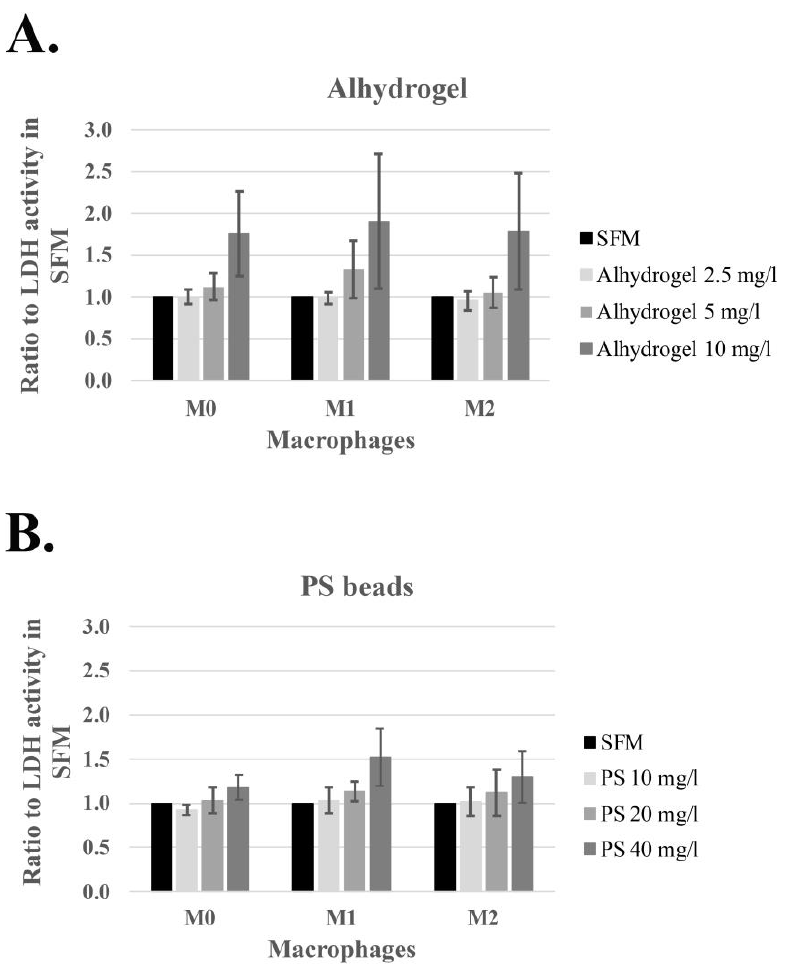
Figure 2. Increased LDH activity in culture medium from differentiated and polarized M0, M1, and M2 macrophages incubated for 24 h with Alhydrogel ® ( A ) and PS beads ( B ), average +/ − standard deviation.